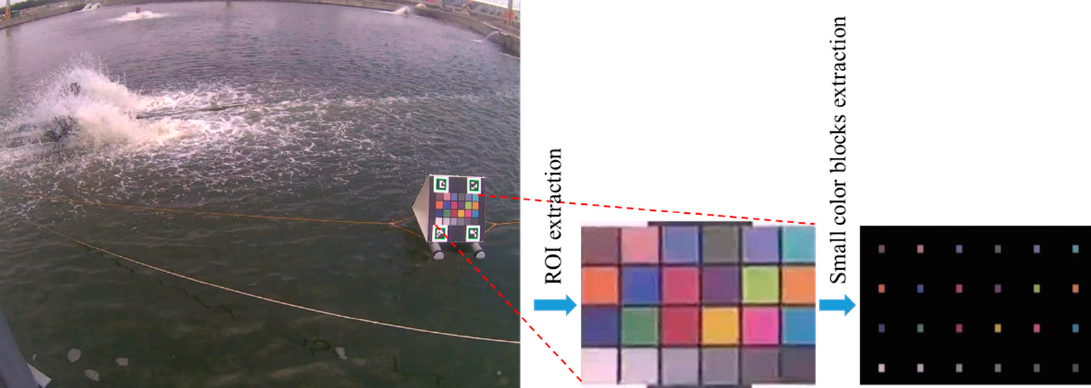
Figure 4. Results of ArUco marker detection, and ROI and small color blocks extraction.